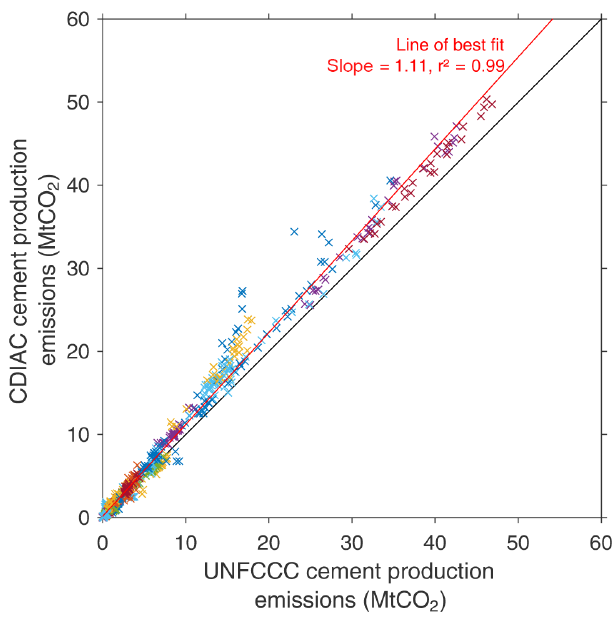
Figure A1. Comparison of CO 2 emissions in 43 countries as esti- mated by CDIAC (Boden et al., 2017) and those officially reported to the UNFCCC, 1990–2015 (UNFCCC,